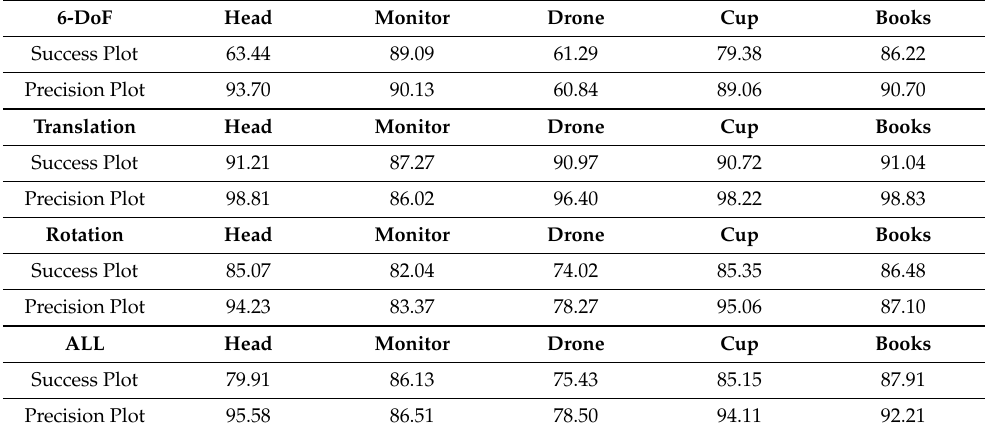
Table 5. Quantitative tracking results (%) of EVtracker.